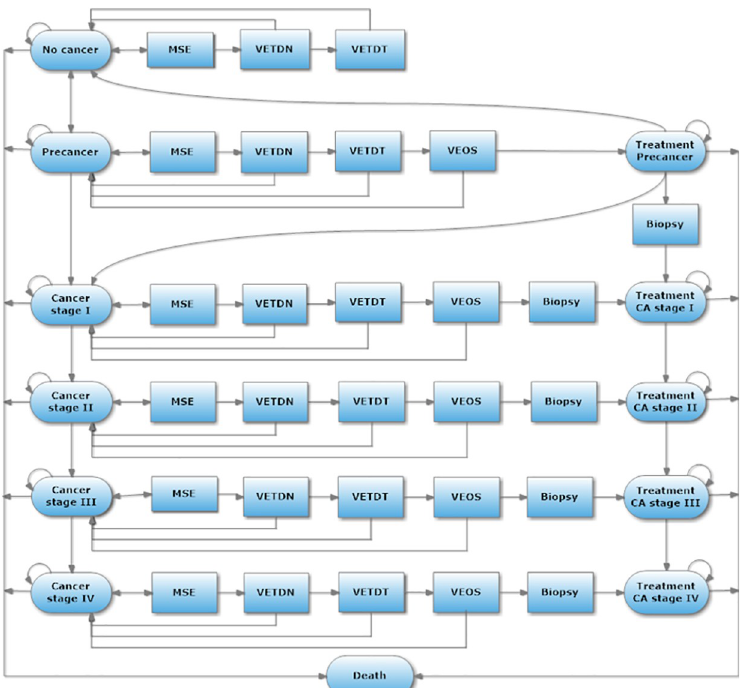
Fig 1. Model of the screening program for early oral cancer detection in